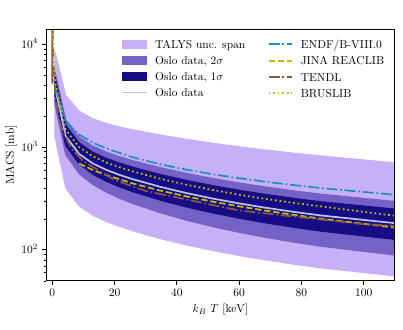
Figure 2. The constrained MACS uncertainty for the ( n ,γ ) 127 Sb reaction, compared to the uncertainty range from combining all the NLD and GSF theoretical models from